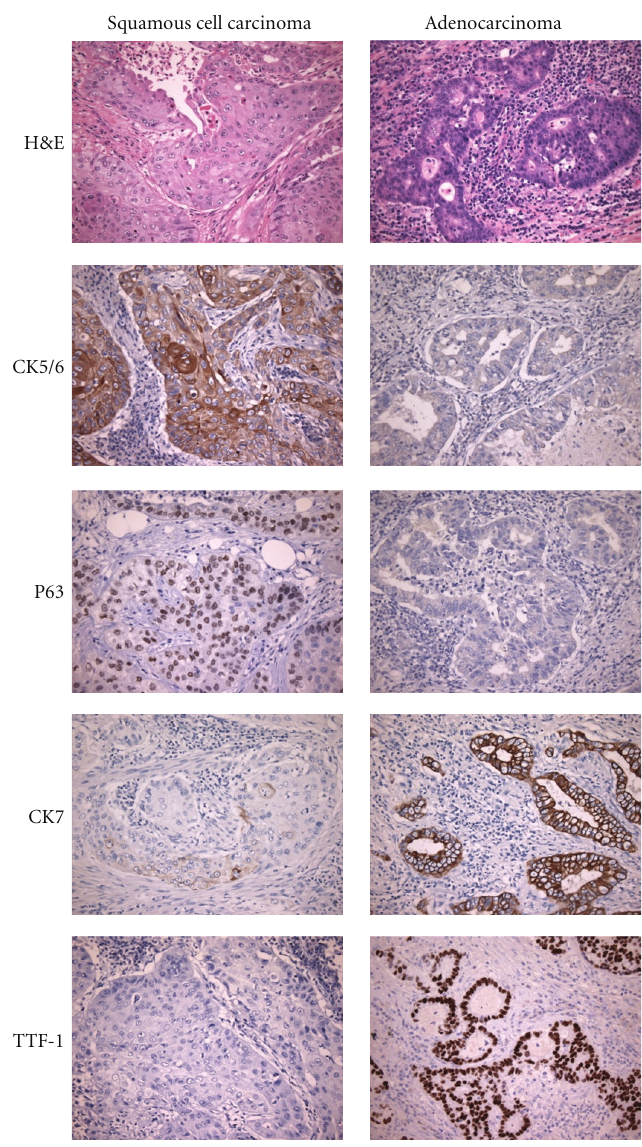
Figure 1: Immunohistochemistry stains in squamous cell carcinoma and adenocarcinoma of lung. H&E: hematoxylin and eosin; CK: cytokeratin; TTF-1: thyroid transcription factor 1. Squamous carcinomas are typically positive for CK5/6 and P63, and negative for CK7 and TTF-1, with the reverse profile for adenocarcinoma although this case of squamous cell carcinoma demonstrates focal weak staining for